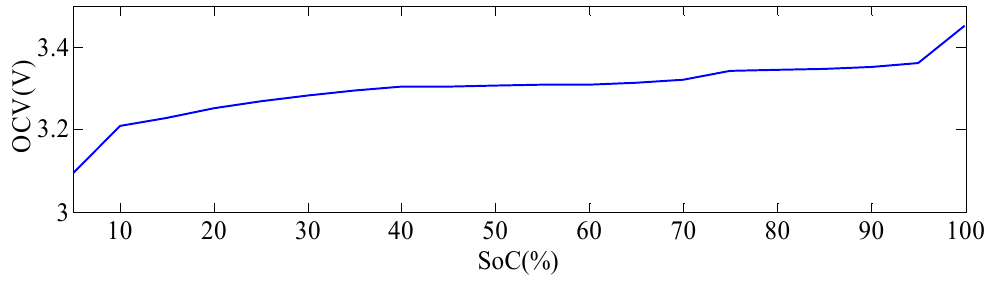
Figure 5. SoC vs . OCV (open circuit voltage) of the LiFePO 4